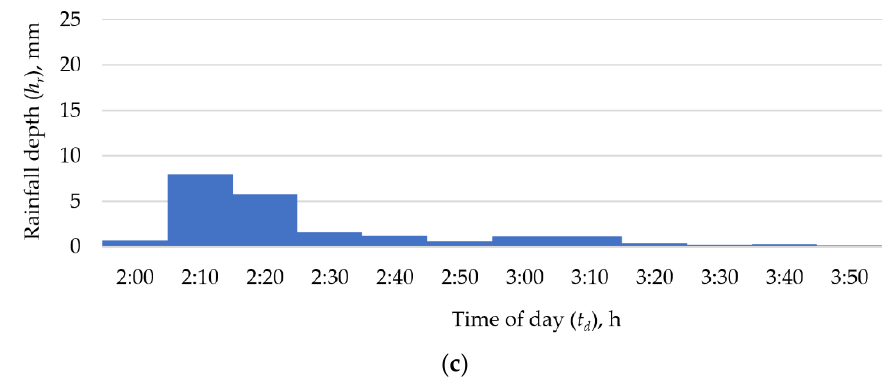
Figure 10. Depth of the analyzed rainfall: ( a ) 19 June 2020 — p = 0.00098; ( b ) 19 May 2019 — p = 0.065; ( c ) 8 August 2019 — p = 0.53.